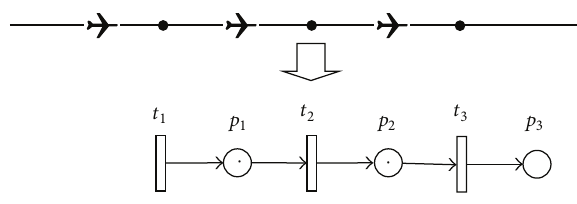
Figure 1: Constraint-free state transition